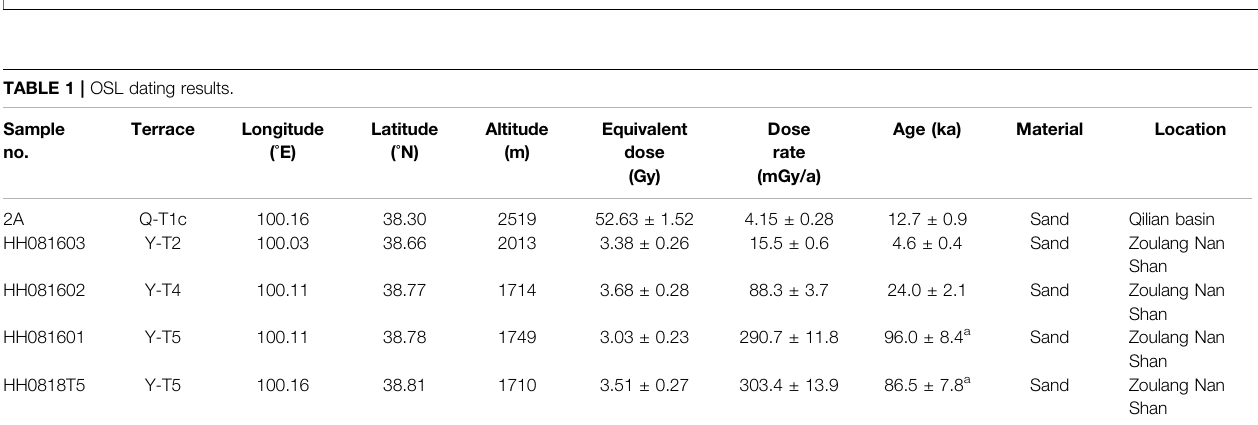
FIGURE5|(A – C) Equivalentdose(De)distributions. (D) DecaycurvesforsampleHH081603. (E) OSLgrowthcurvesofindividualaliquots,aswellastheSGC(the bold red line), for sample HH081603.